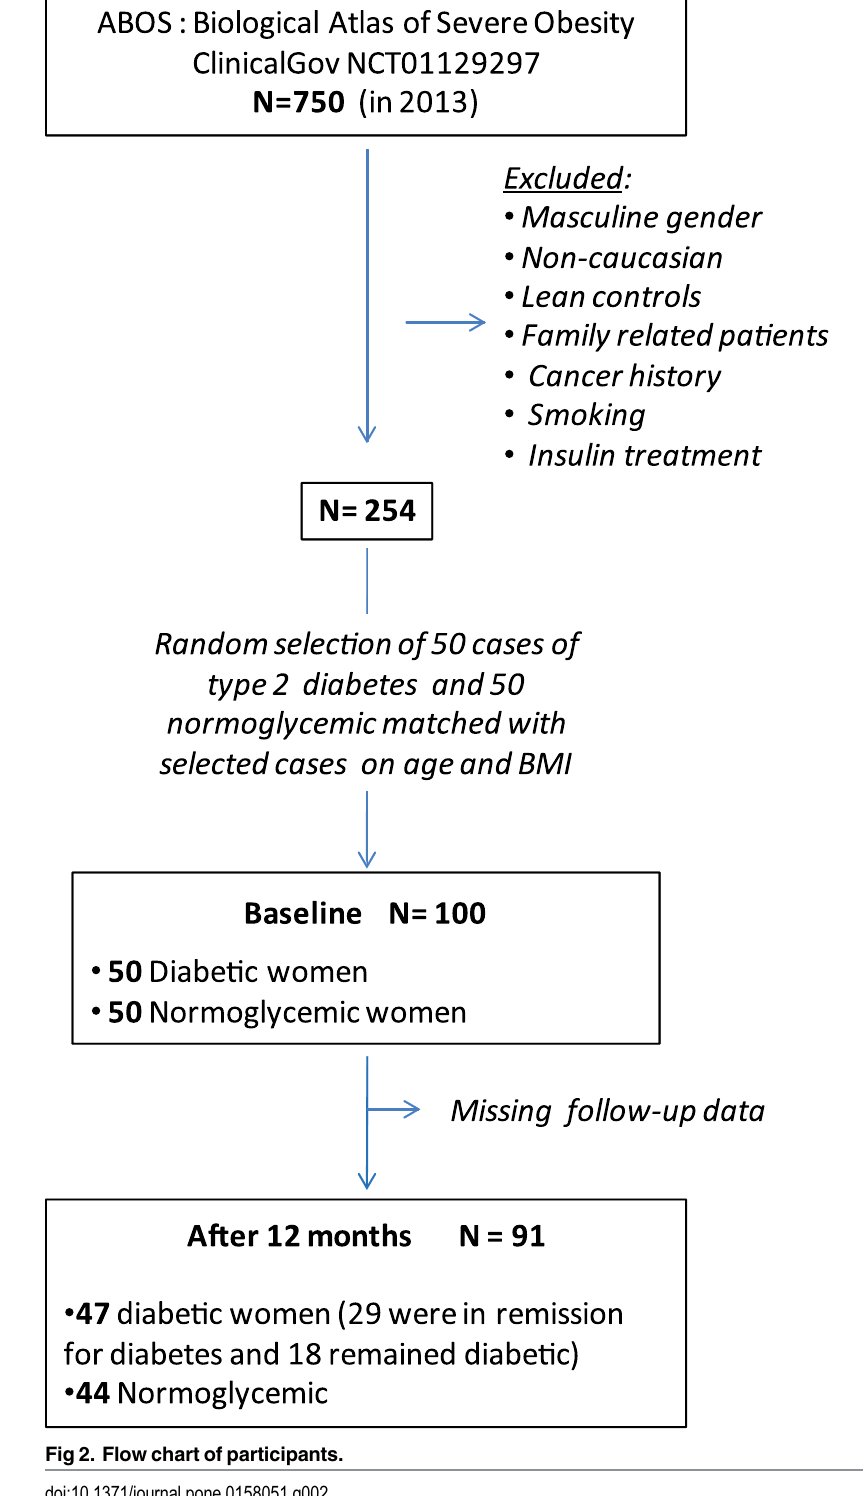
PLOS ONE | DOI:10.1371/journal.pone.0158051 June 21,